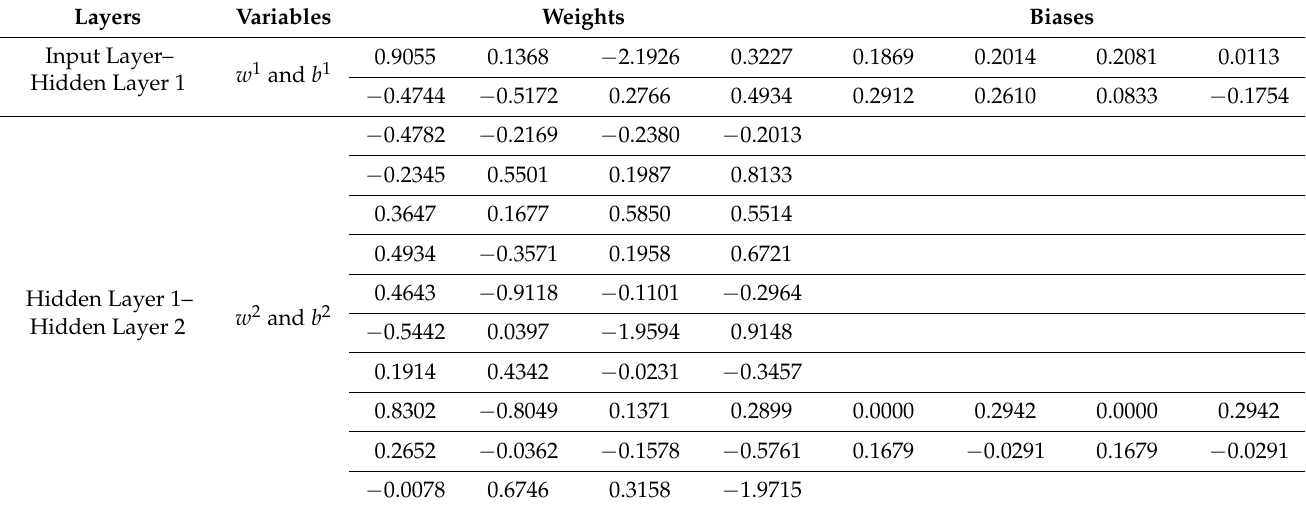
Table 9. Weights and biases of the developed ANN